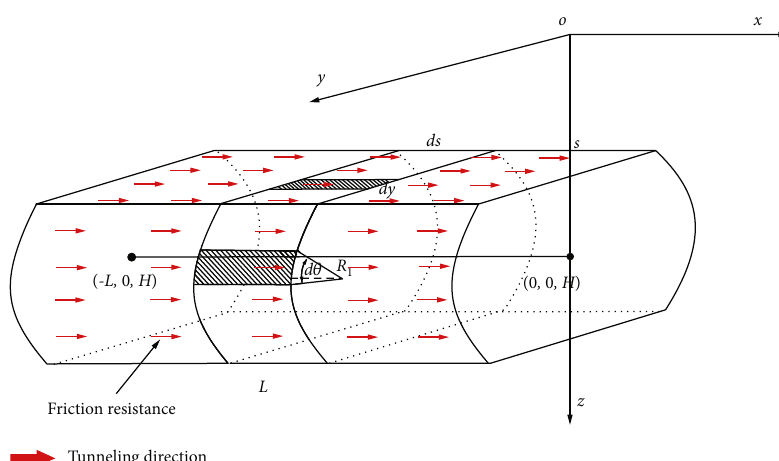
Figure 5: The calculation diagram of additional stress induced by shield